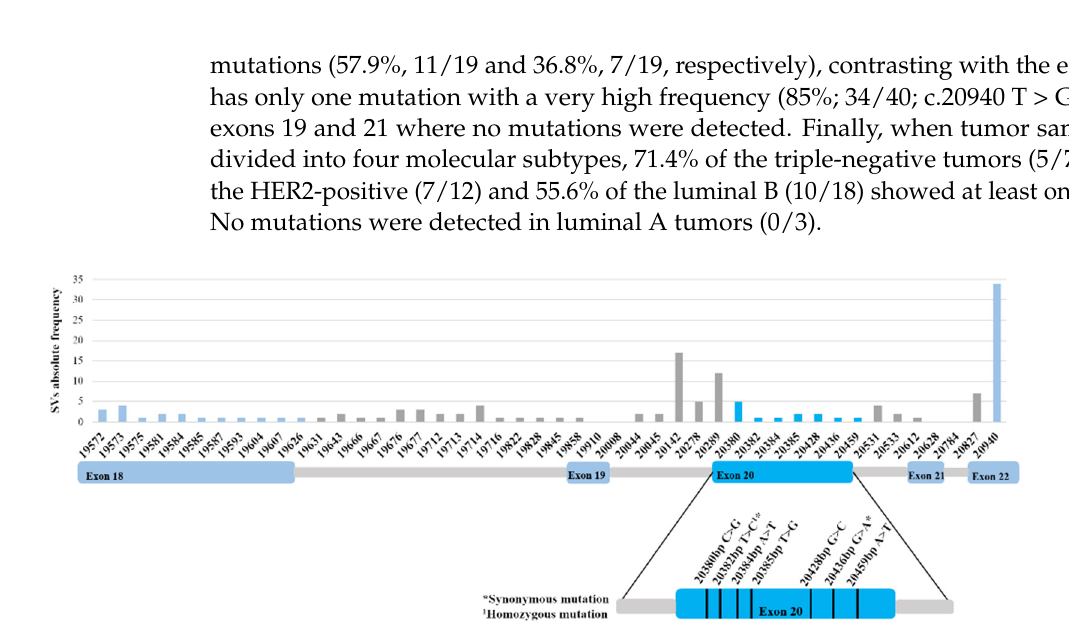
Figure 5. Mutations identified in feline her2 TK domain are not reported to induce therapeutic resistance in woman breast cancer. Most of the detected mutations were localized at intronic regions, although some of them were identified in exons, as a very frequent mutation in the exon 22 (c.20940 T > G; 85%; 34/40). Regarding the exon 20 that encodes for the protein region recognized by TKi, none of the seven identified mutations were reported as being related to therapeutic resistance in woman breast cancer.